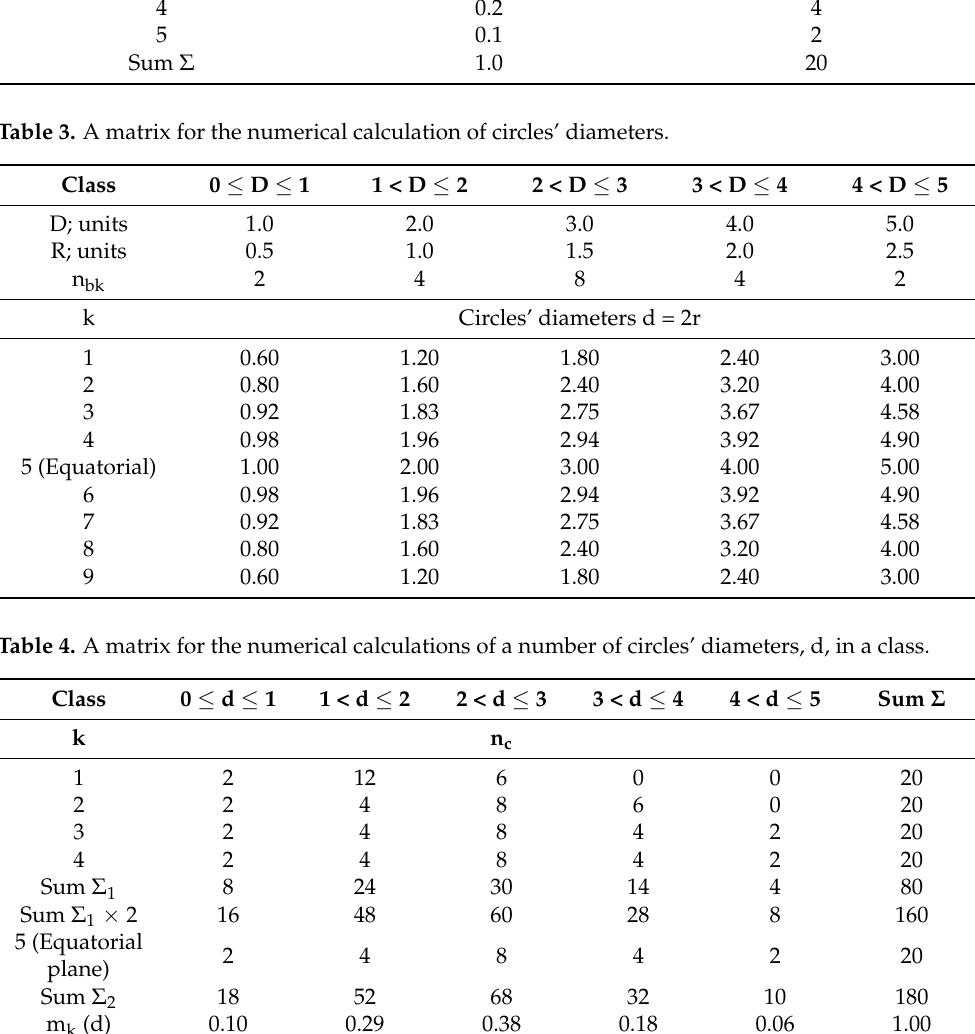
Table 3. A matrix for the numerical calculation of circles’ diameters.